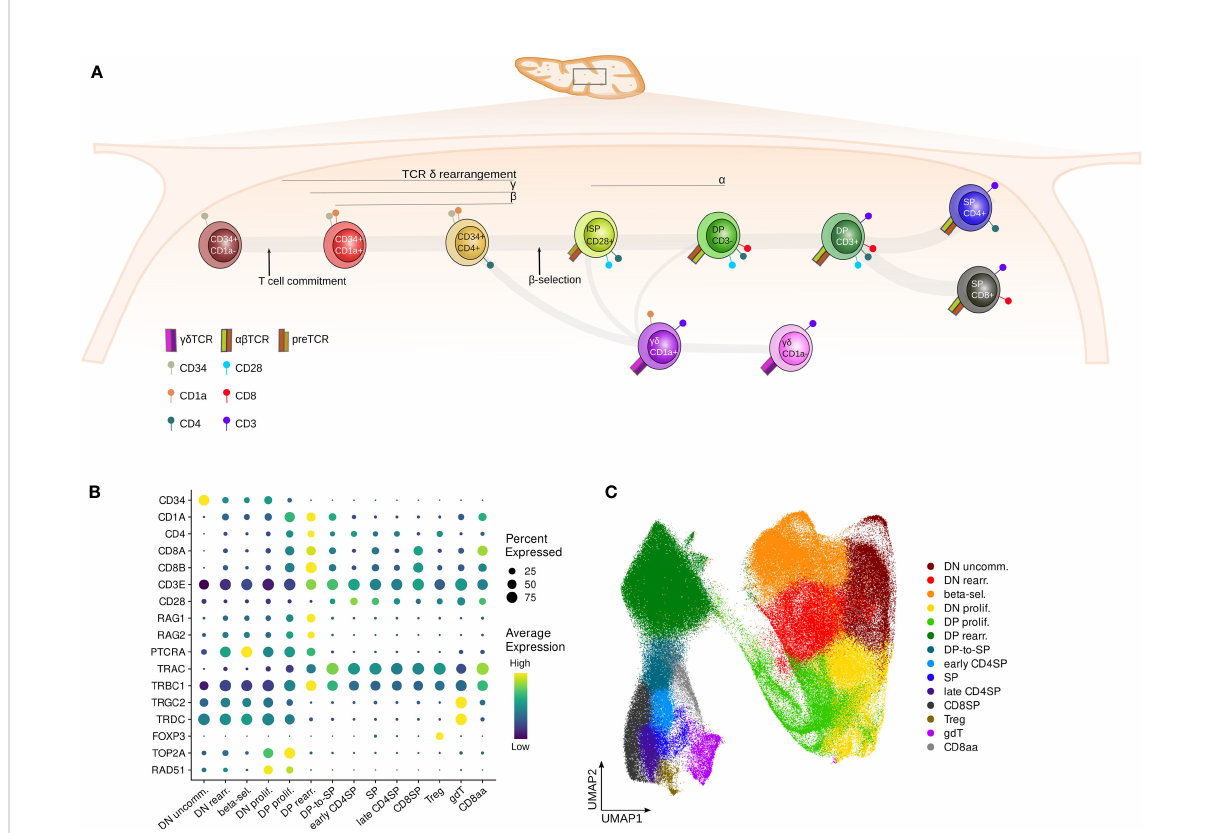
FIGURE 1 Surface markers distinguish subsequent stages of human thymocyte development. (A) Schematic depiction of stages of T cell development in the human thymus. (B) Dot plot visualizing pseudo-bulk expression of known thymocyte markers per annotated cluster in the pediatric single cell data set. Non-imputed data was log-normalized, averaged and scaled by gene. (C) UMAP visualizing the annotated clusters in the pediatric single cell thymus data